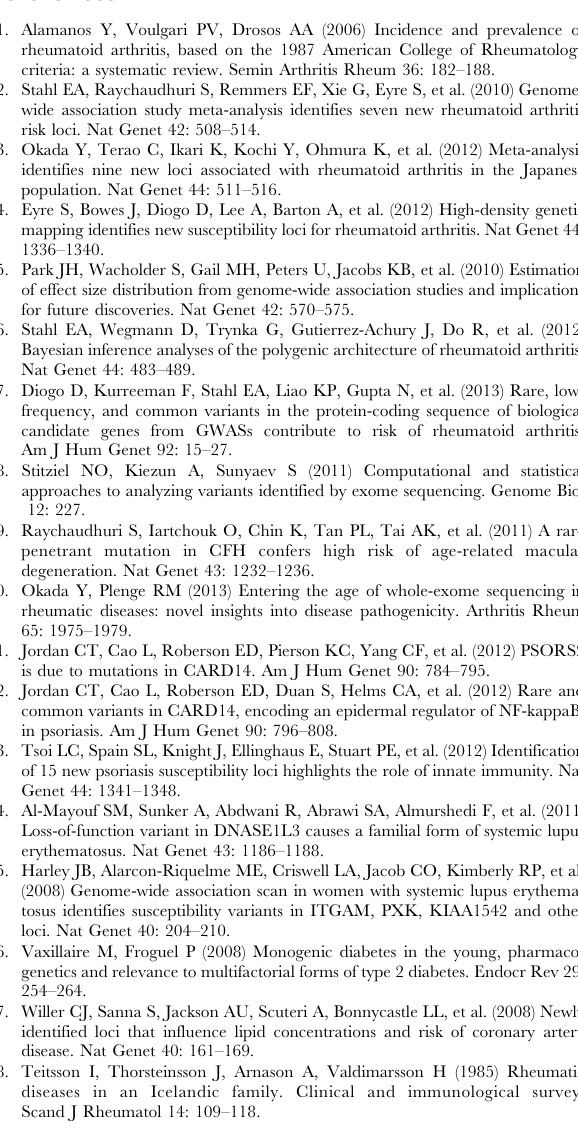
Table S1 Characteristics of RA cases and a ACPA- positive unaffected subject in the consanguineous ped- igree with RA. Table S2 Results of IBD mapping for the consanguin- eous pedigree with RA. Table S3 A list of the filtered variants from whole exome sequencing. Table S4 Characteristics of the subjects in European RA case-control cohorts.